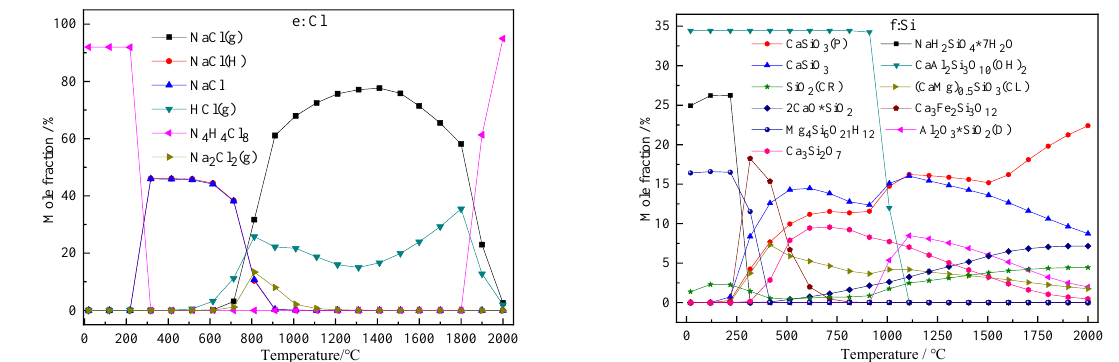
Figure 1. Effect of incineration temperature on the migration and transformation of the major elements in ash. ( a ): Na, ( b ): K, ( c ): Ca, ( d ): Mg, ( e ): Cl, ( f ): Si. The asterisk in the chemical formula shows that the molecules or species are attached with each other as independent species, similarly hereinafter.